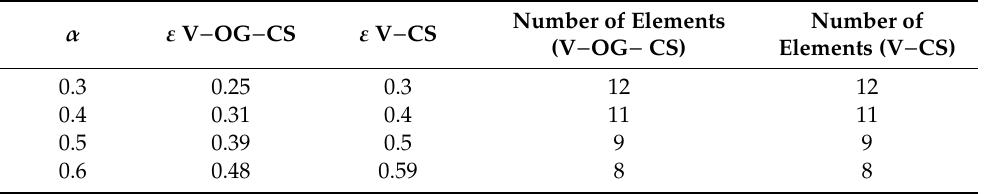
Number of (V − OG − CS) Elements (V − CS)